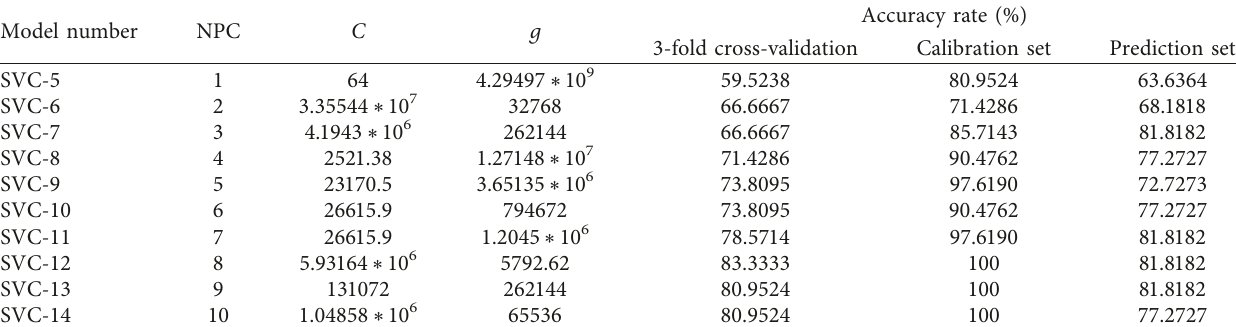
Table 4: Comparison on PCA-SVC models established with different